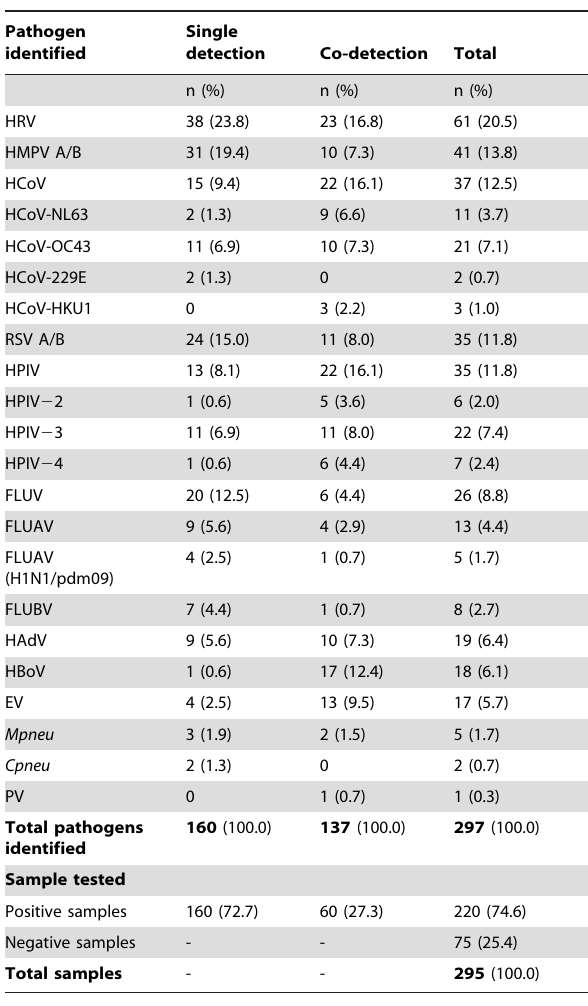
Table 1. Pathogens prevalence among outpatient children aged from 2 to 59 months living in Ampasimanjeva district between February 2010 and February 2011.